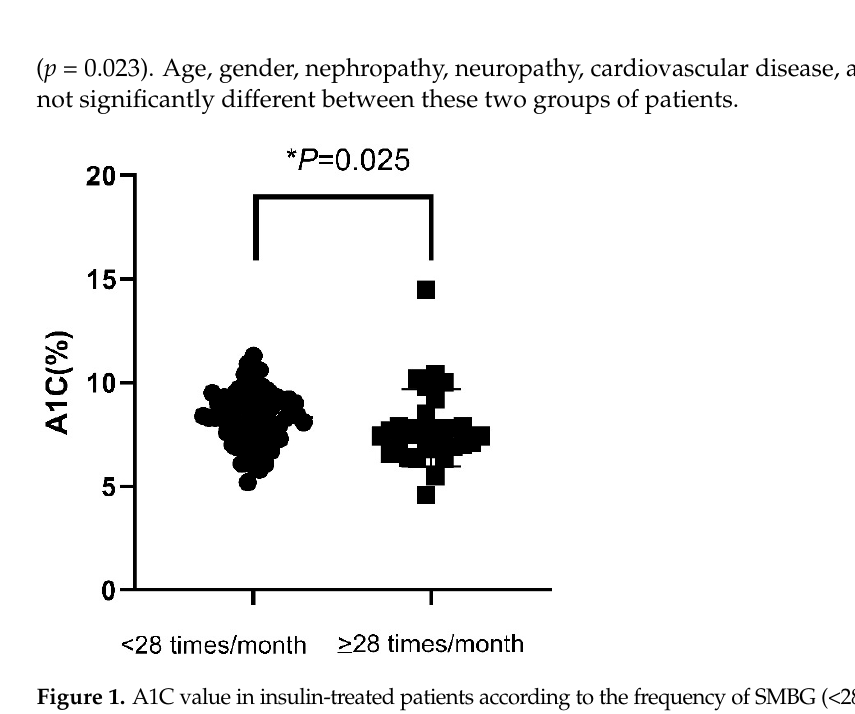
Table 4. Behavior of SMBG restricted to patients who checked SMBG in the past 1 month ( n = 249).